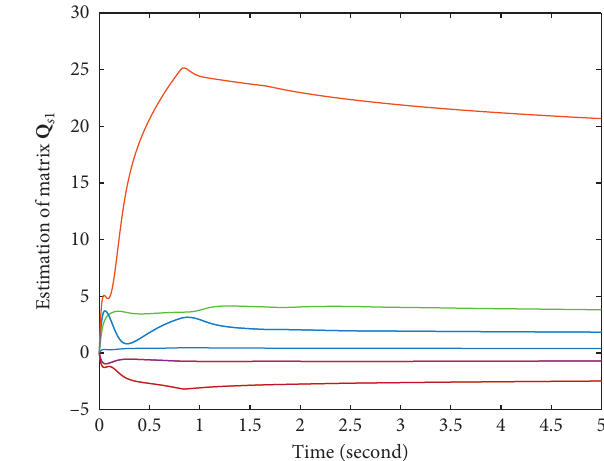
Figure 3: Estimated parameters for matrix Q